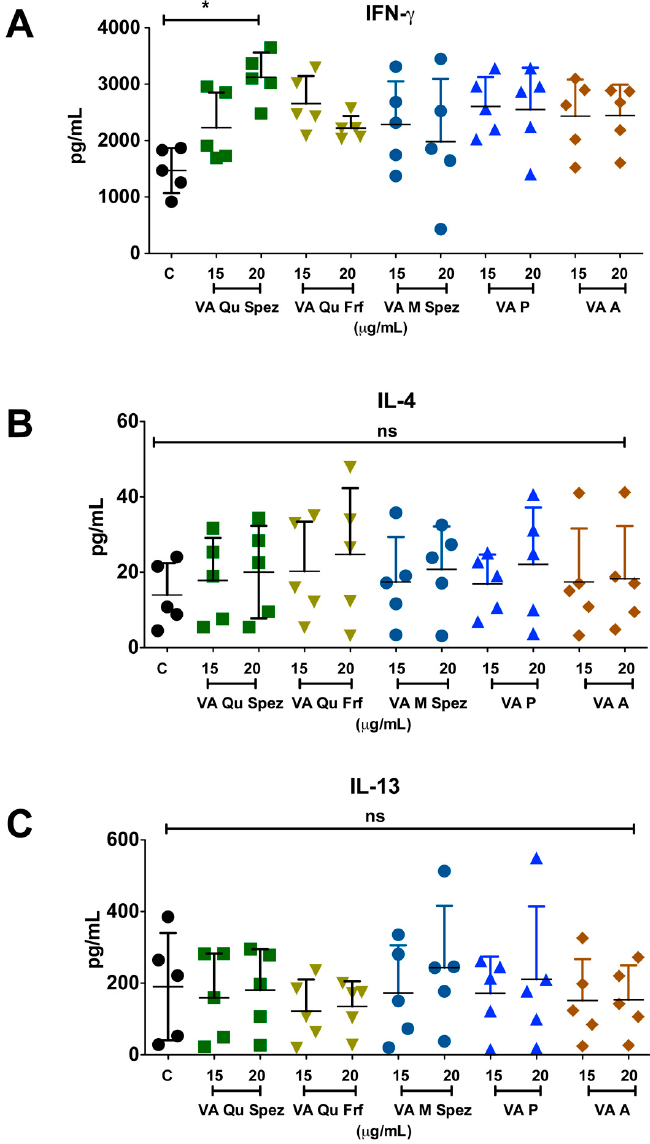
Figure 4. Cont. Figure 4.